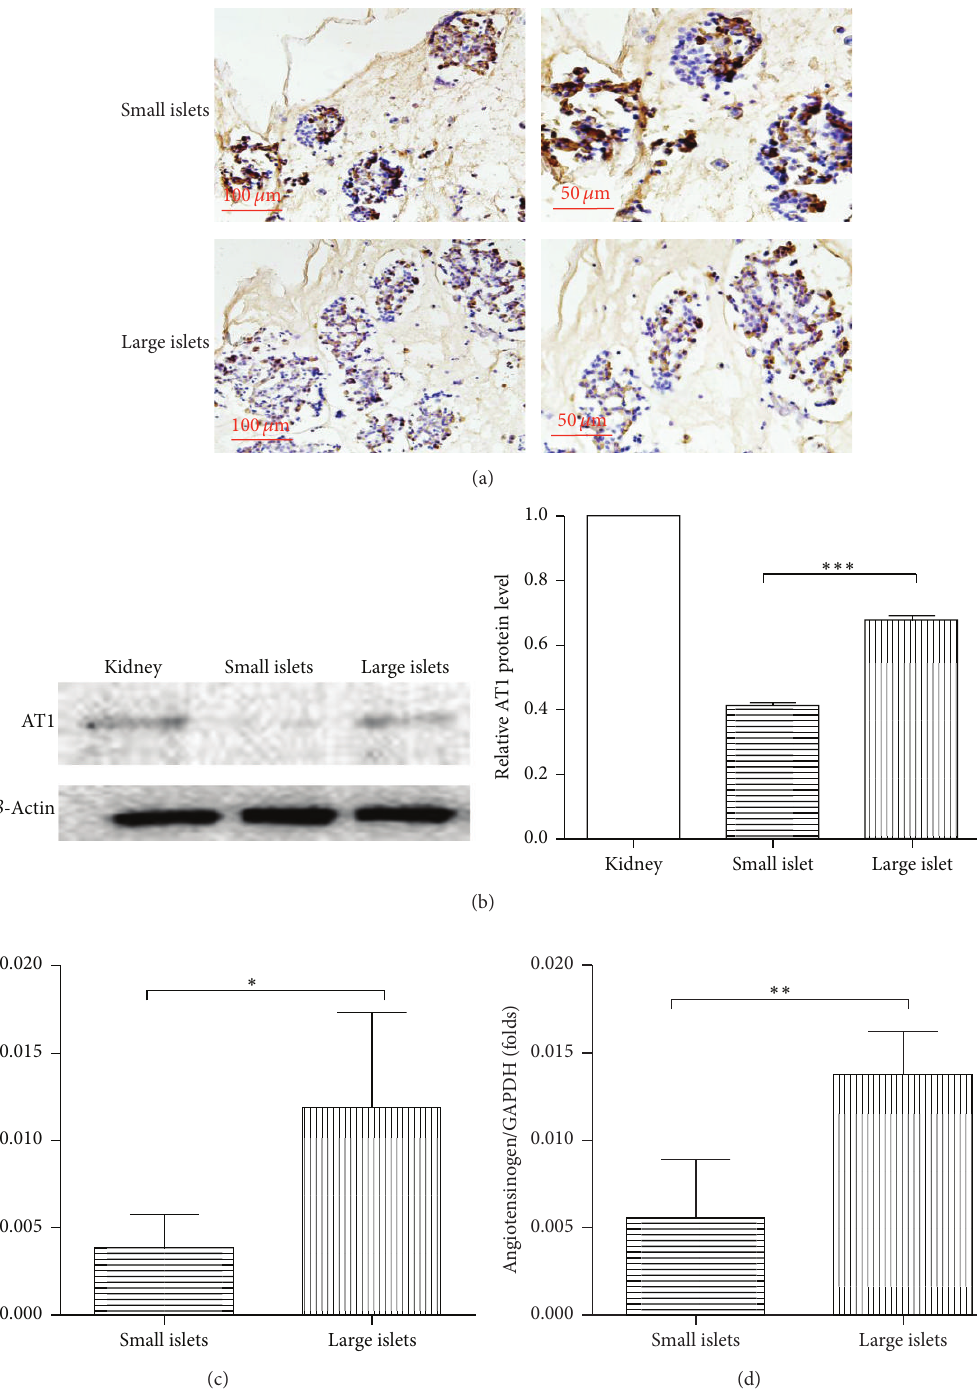
Figure 5: Small islets with less intrinsic Ang II-AT1 tension are nourished by adequate microcirculation. (a) Immunostains of CD31 (brown) in islets in situ from the sectioned pancreas. Small islets are embedded in a more adequate microcirculation reflected by a darker vascular endothelial marker staining. Quantification of local AT1 receptor expression by western blot (b)and qRT-PCR.(c)AT1 receptor issignificantly less intensively expressed in small islets at both mRNA ( 𝑃 = 0.0321 ) and protein ( 𝑃 = 0.0007 ) levels. (Protein from the kidney tissue was arranged as positive control.) (d) The qRT-PCR analysis of angiotensinogen. Small islets again expressed less angiotensinogen verified at mRNA levels ( 𝑃 = 0.0079